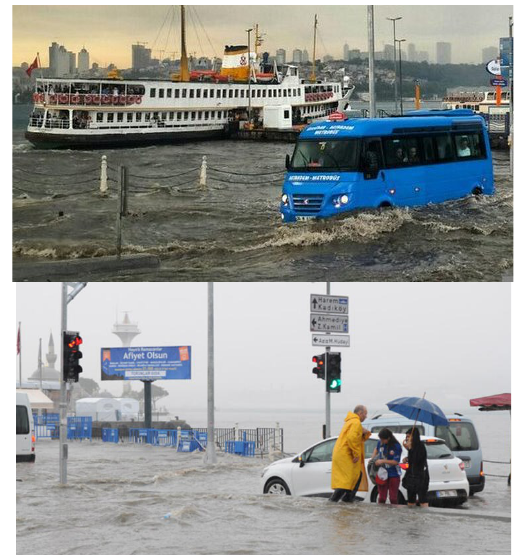
Figure 8. The floods cause to the scenes that the citizens were neither familiar with nor prepared before